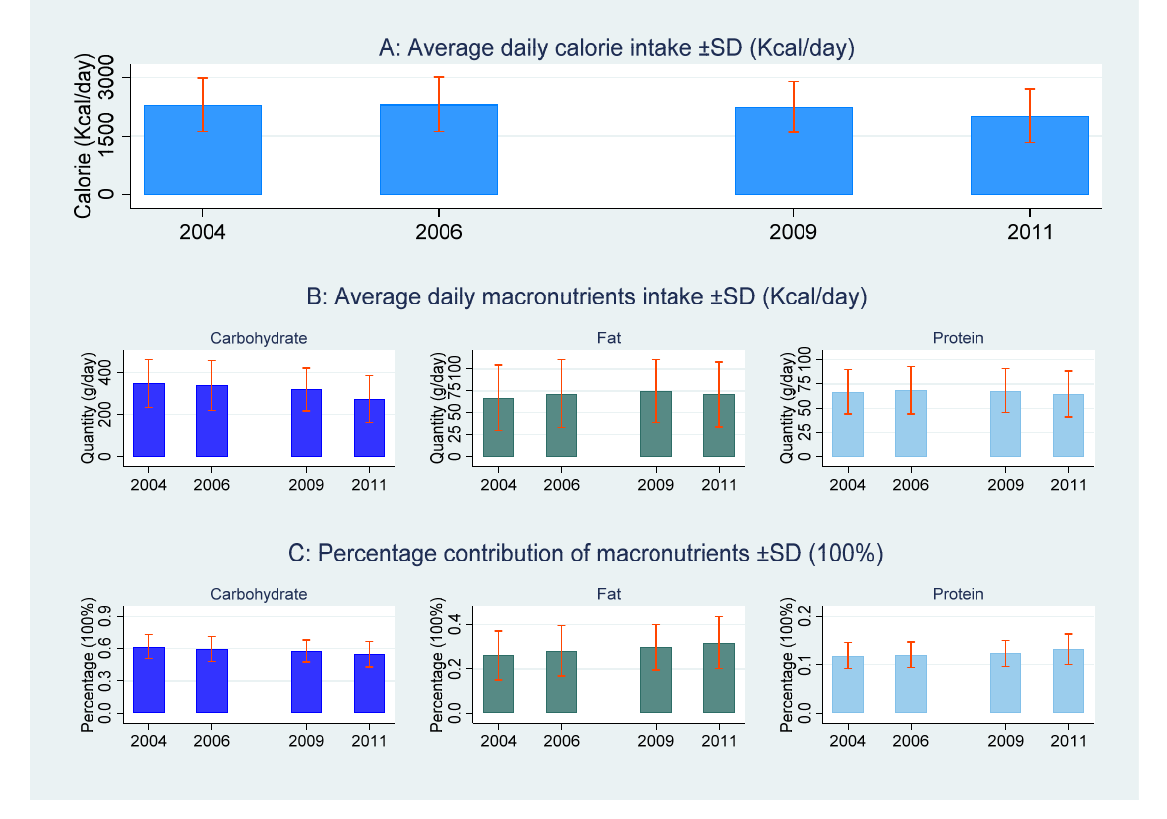
Figure 1. The trend of total calorie intakes and macronutrients from 2004 to 2011.